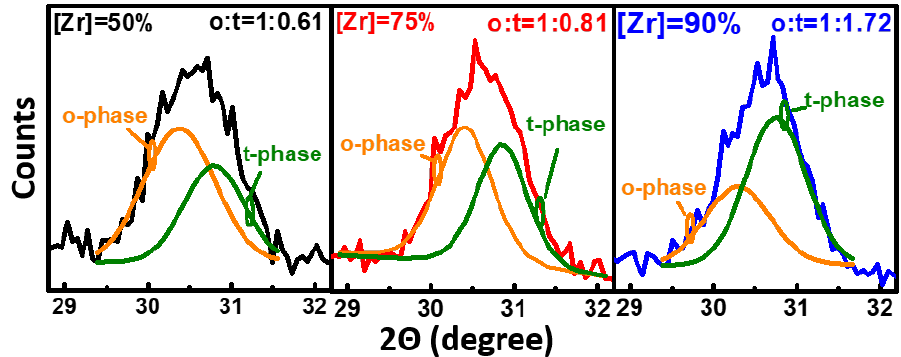
Figure 4. The grazing-incidence XRD (GIXRD) pattern of the HZOs for the [Zr] = 50%, 75%, and 90% diodes. The ratios of the o:t phases are extracted as 1:0.61, 1:0.81, and 1:1.72, respectively, by fitting the peak at 30 – 31°.